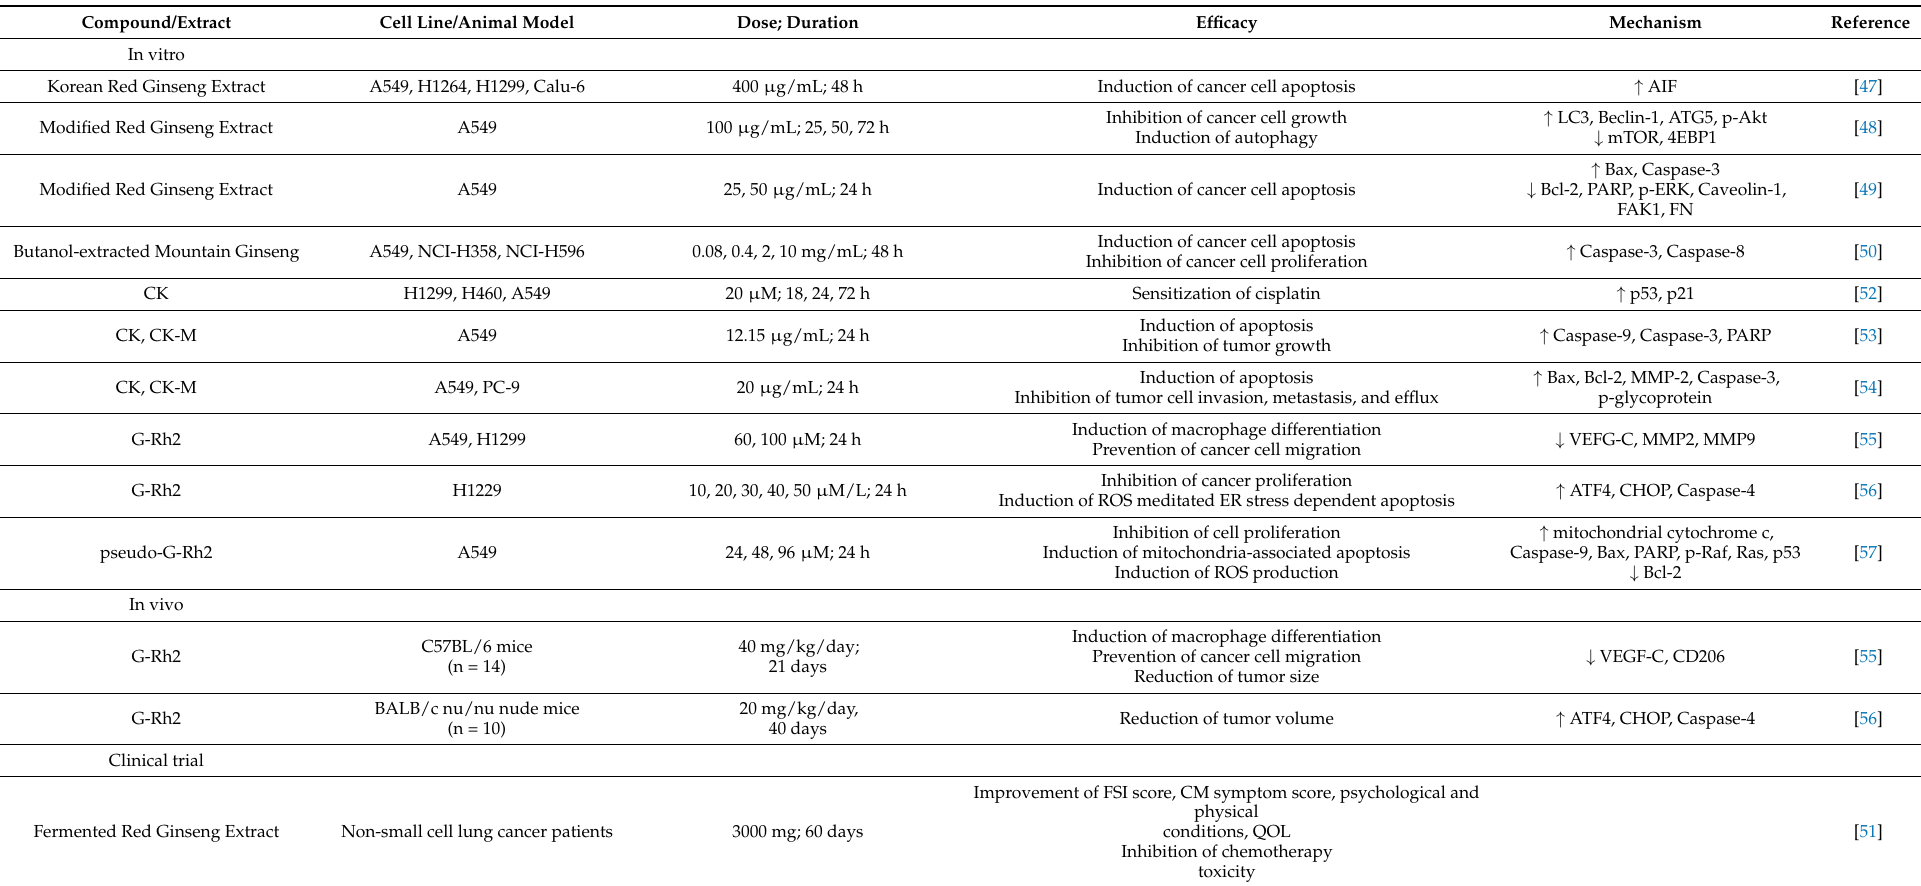
Table 1. Panax ginseng and its metabolites against lung